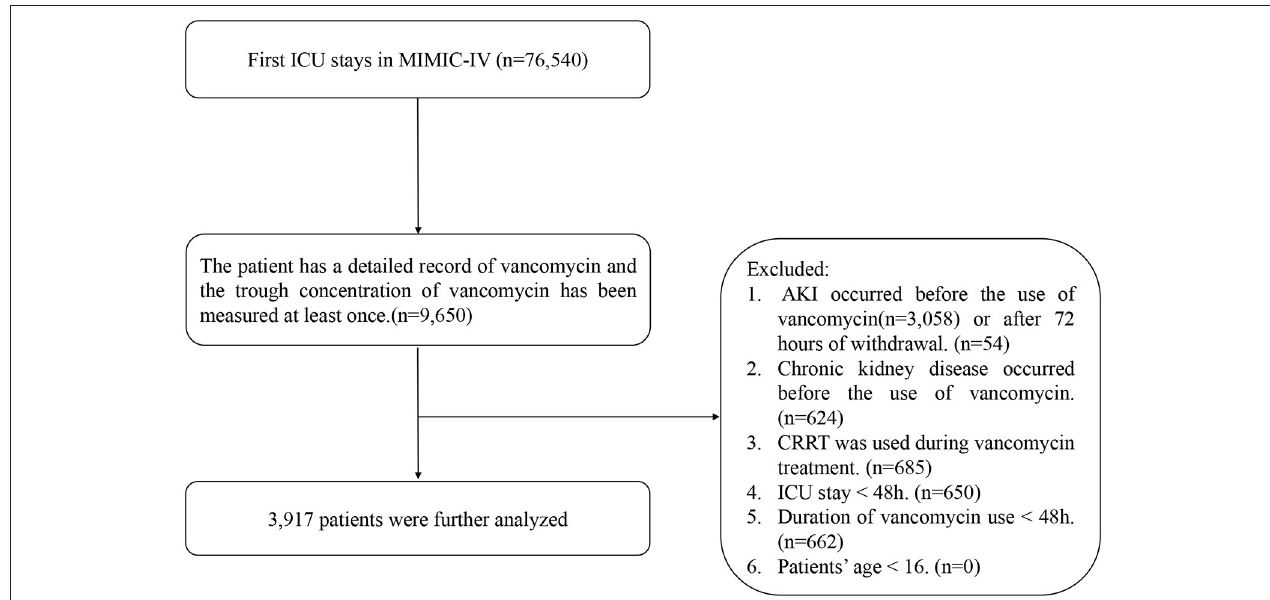
FIGURE 1 | Flowchart of study population